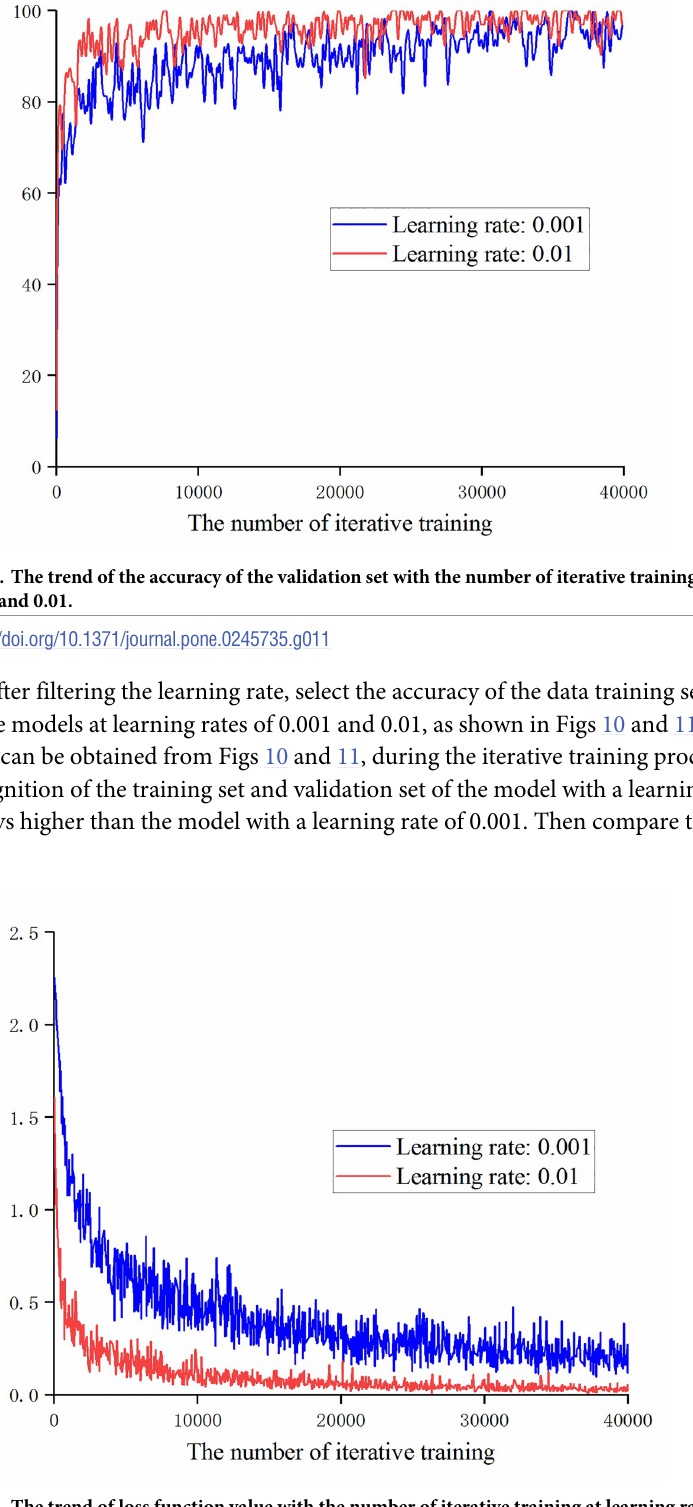
Fig 12. The trend of loss function value with the number of iterative training at learning rates of 0.001 and